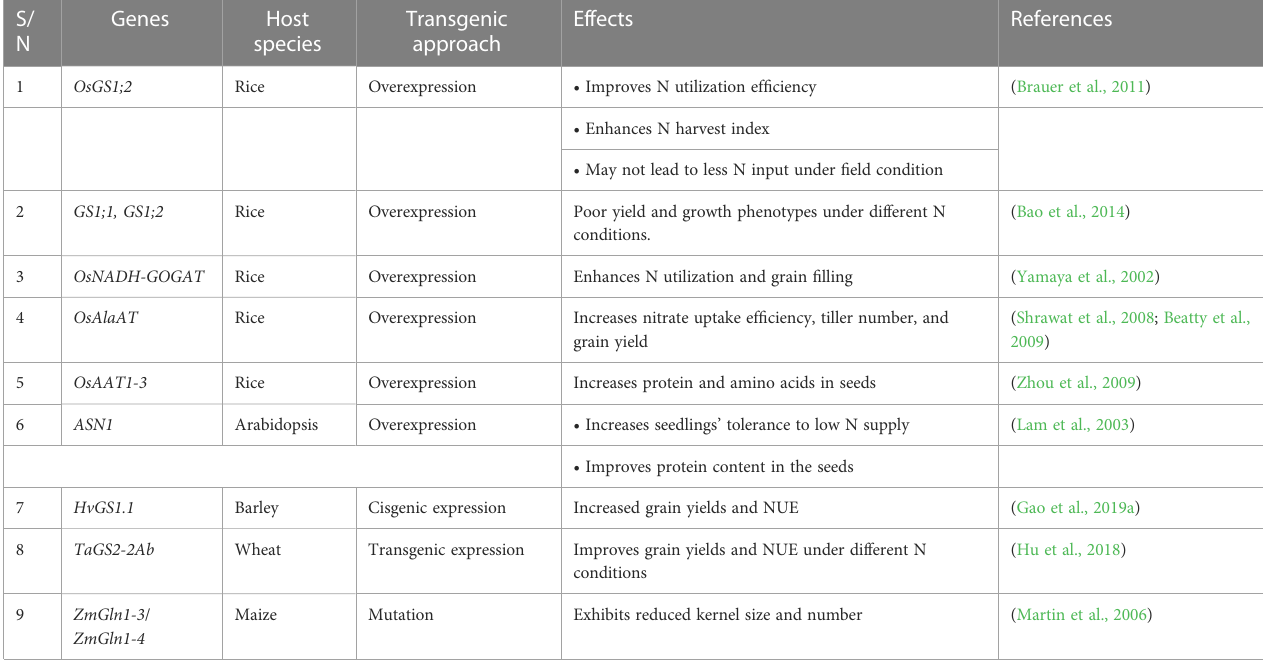
TABLE 1 Nitrogen assimilatory genes involved in nitrogen use ef fi ciency. S/